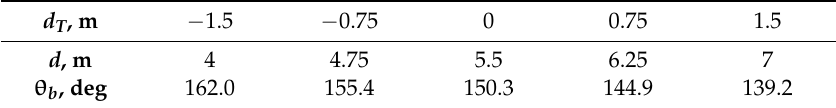
Table 2. Value of beak angle at different tidal